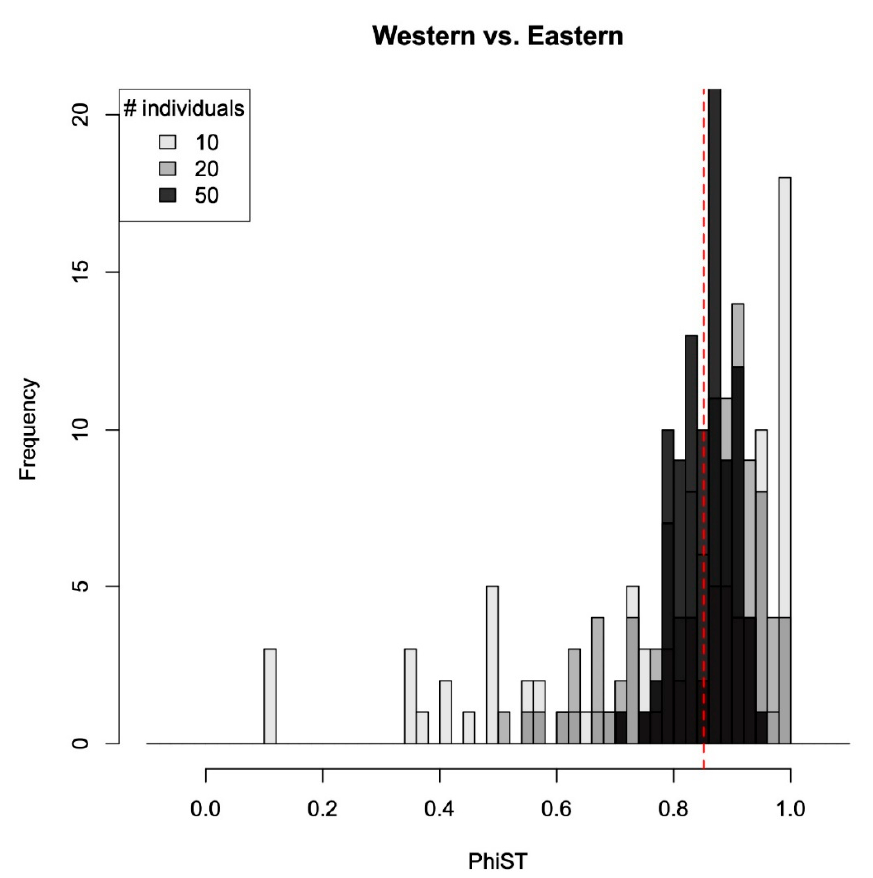
Figure 6. The fixation indices ( Φ ST) calculated between western and eastern populations. The red dashed line indicates the original estimated value (86 individuals from western and 100 individuals from eastern populations).